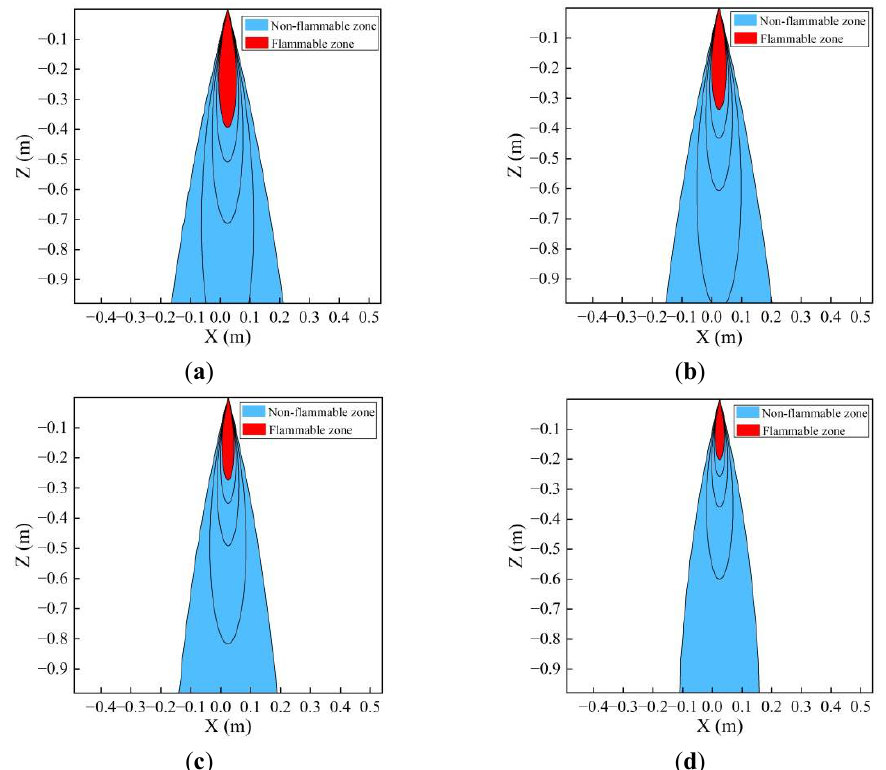
Figure 14. Variations in the flammable area of the external space under different initial leakage pressures: ( a ) 2; ( b ) 1.5; ( c ) 1; ( d ) 0.5 MPa.